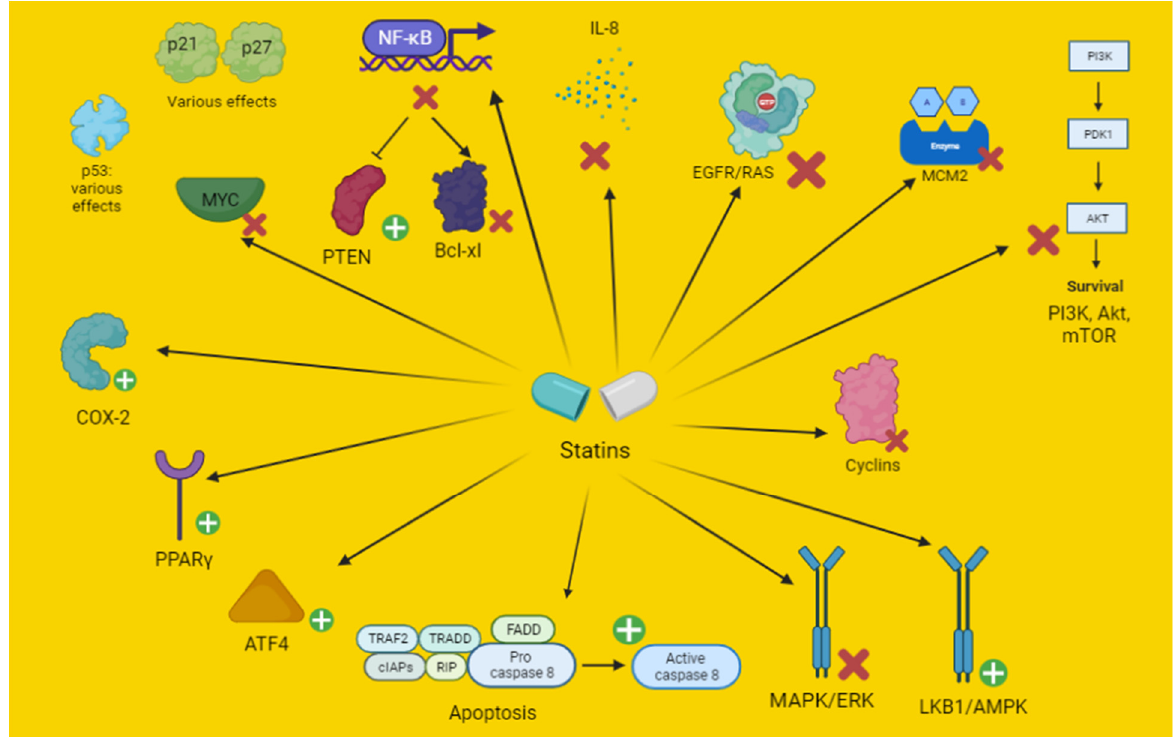
Figure 1. Schematic representation of the effect of statins on the mechanisms of apoptosis. Akt, protein kinase B; COX, cyclooxygenase; AMPK, 5 ′ adenosine monophosphate-activated protein kinase; ATF, activation of transcription factor; EGFR, epithelial growth factor receptor; ERK, extracellular signal-regulated kinases; FADD, Fas-associated protein with death domain; IAP, inhibitor of apoptosis; IL, interleukin; LKB1, liver kinase B1; MAPK, mitogen-activated protein kinase; MCM, minichromosome maintenance; mTOR, mechanistic target of rapamycin; MYC, myelocytomatosis (similar oncogene); NF κ B, nuclear factor kappa B; PI3K, phosphoinositide 3-kinases; PPAR- γ , peroxisome proliferator-activated receptors-gamma; PTEN, phosphatase and tensin homolog; RIP, receptor interacting protein; TRADD, tumor necrosis factor receptor type 1-associated death domain protein; TRAF, TNF-receptor associated factors.